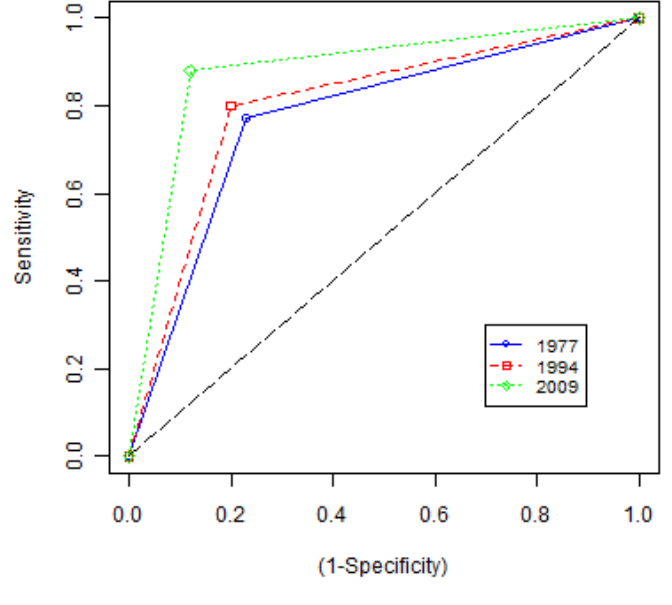
Figure 4. ROC curves for urban-extent classifications from Landsat TM and